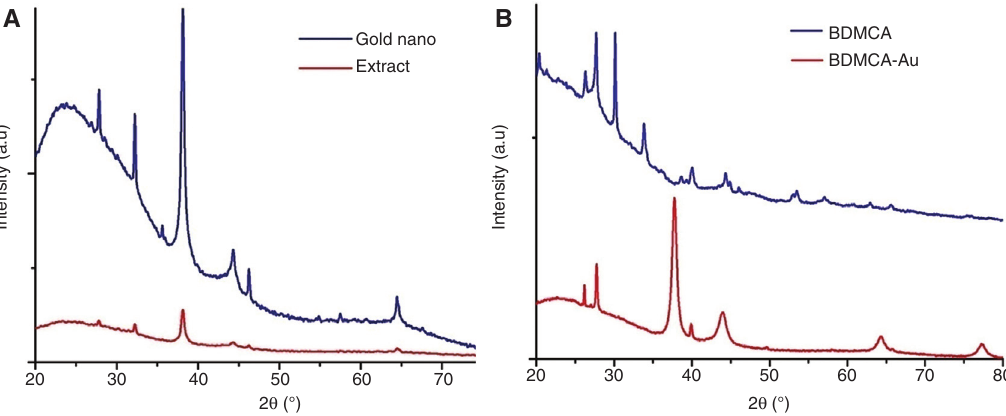
Figure 10 Representative X-ray diffraction (XRD) profile of (A) extract and thin film of gold nanoparticles, and (B) bisdemethoxycurcumin analog (BDMCA) and BDMCA coated gold